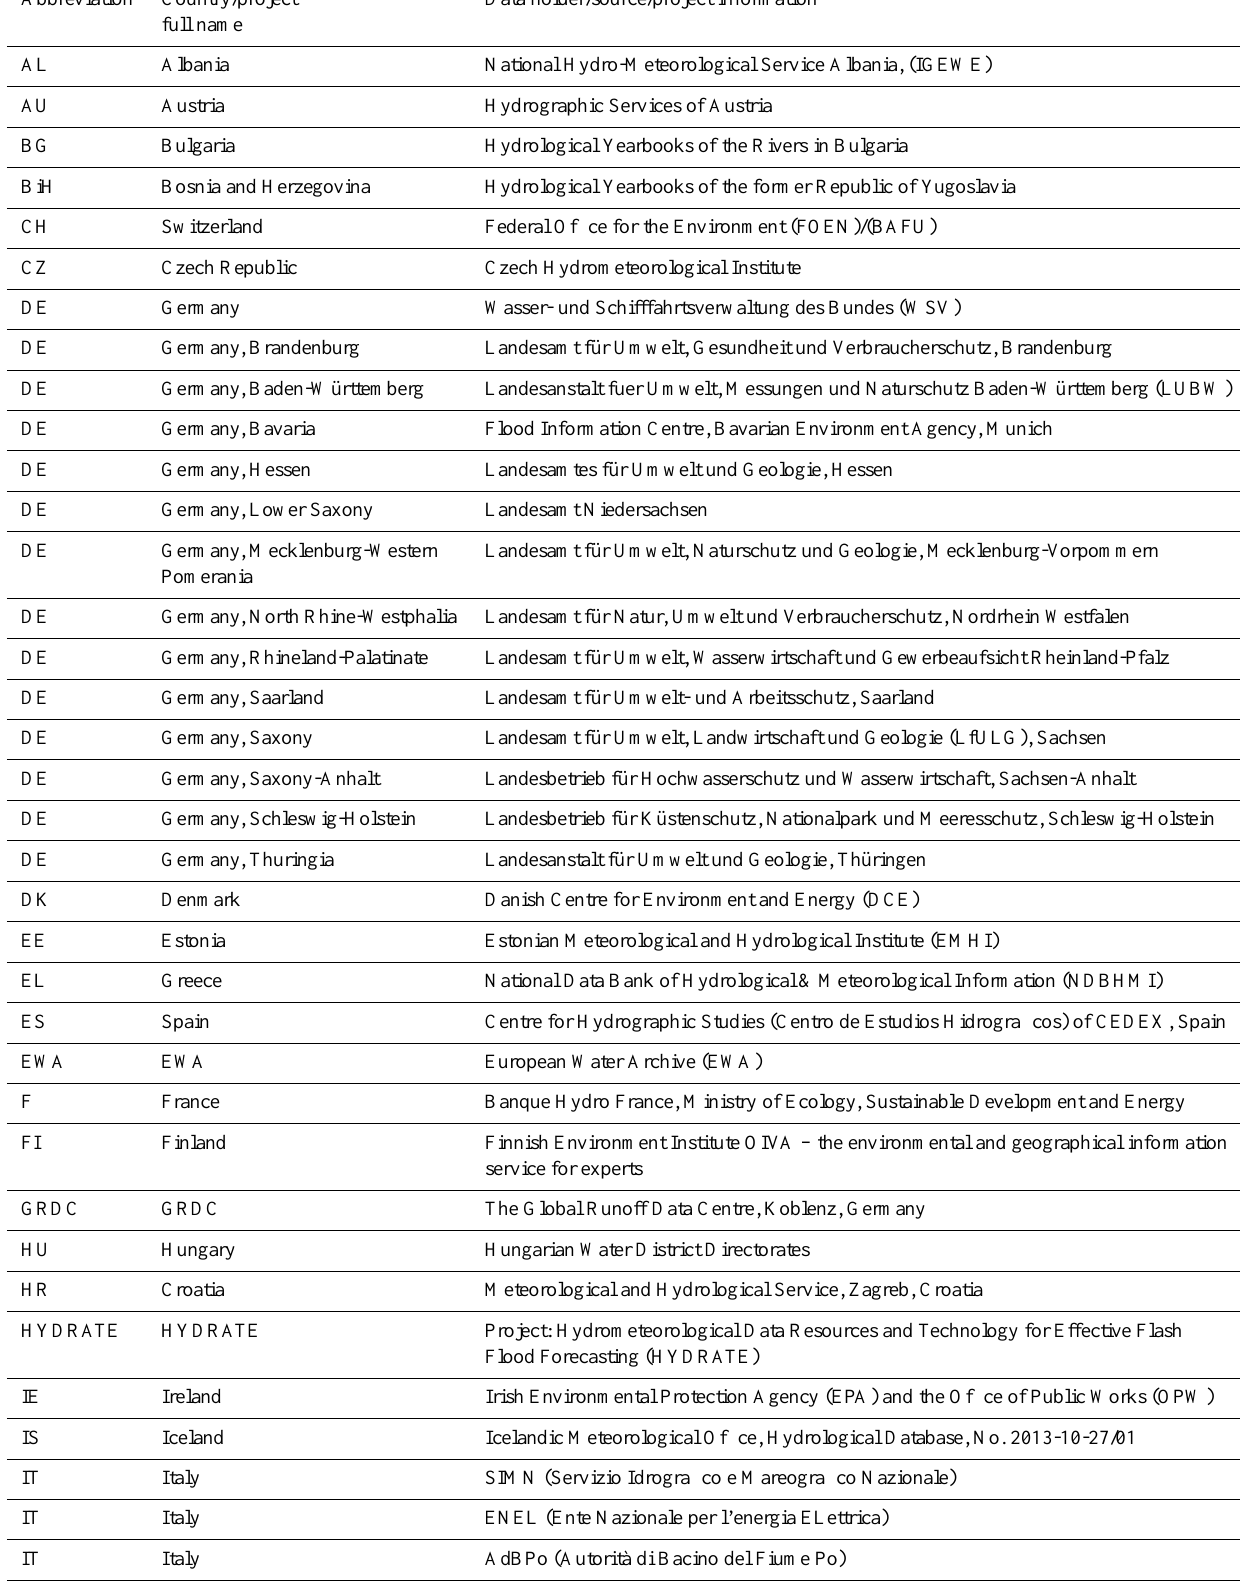
Table 1. Data sources of the European Flood Research